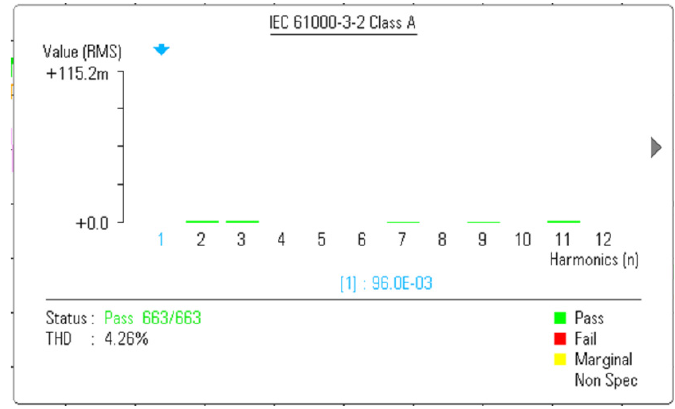
Figure 23. FFT analysis of circulating current in MMC with fuzzy logic controller.